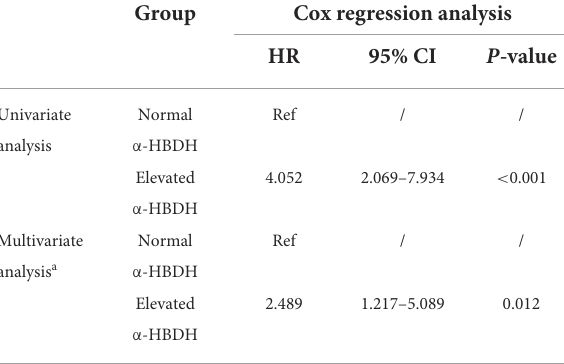
TABLE 3 The risk of elevated α -hydroxybutyrate dehydrogenase for in-hospital death during hospitalization. Group Cox regression